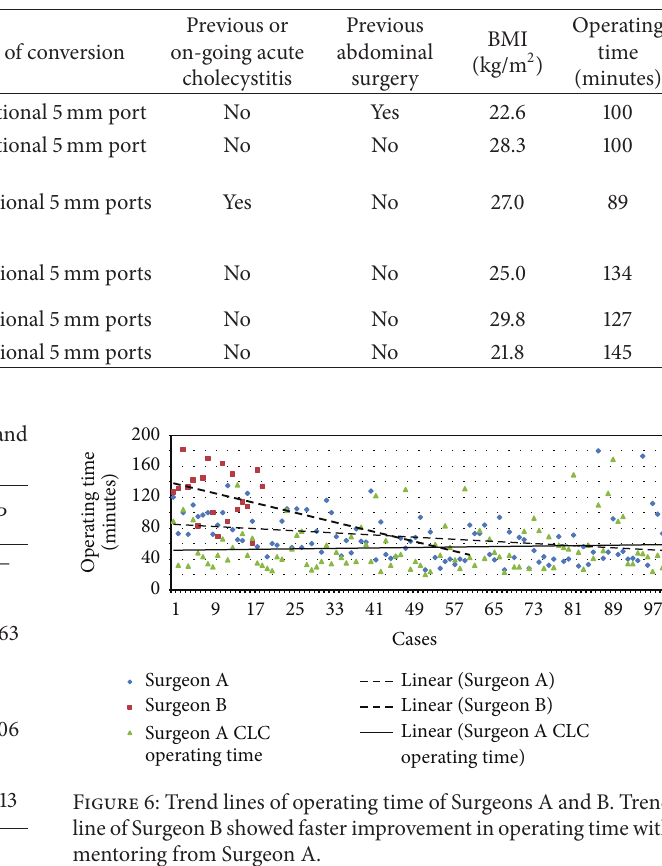
Table 2: Profile of cases that required conversion in the first 19 cases.